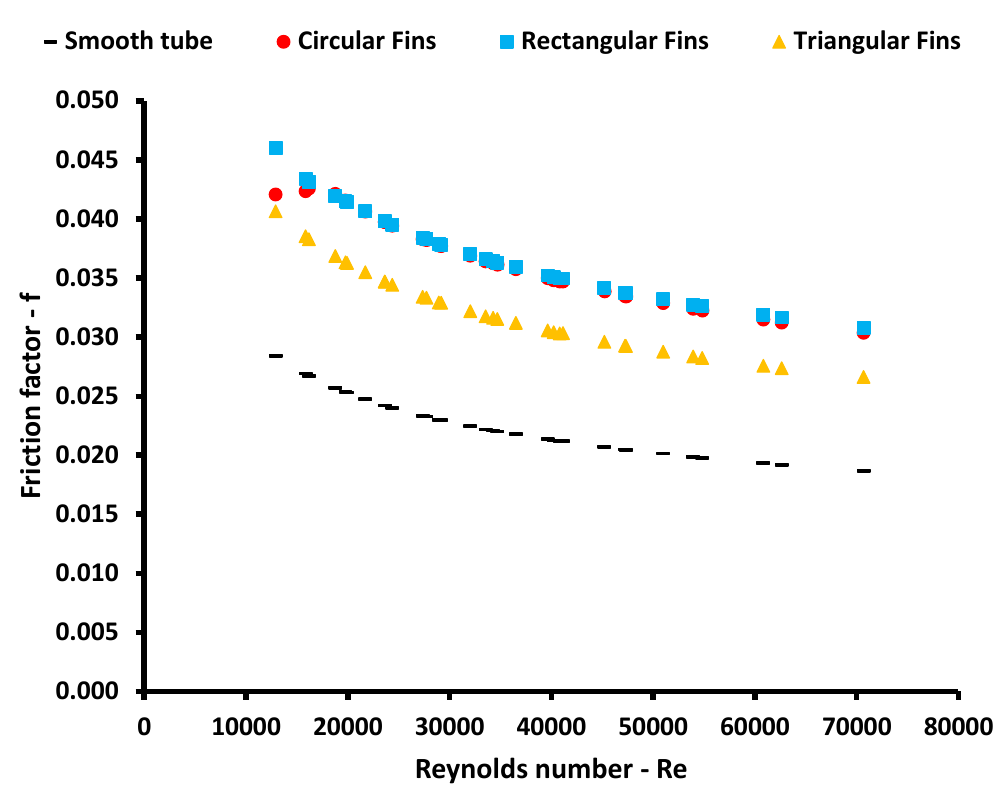
Figure 15. Heat transfer coefficient in the examined cases for all the tubes.